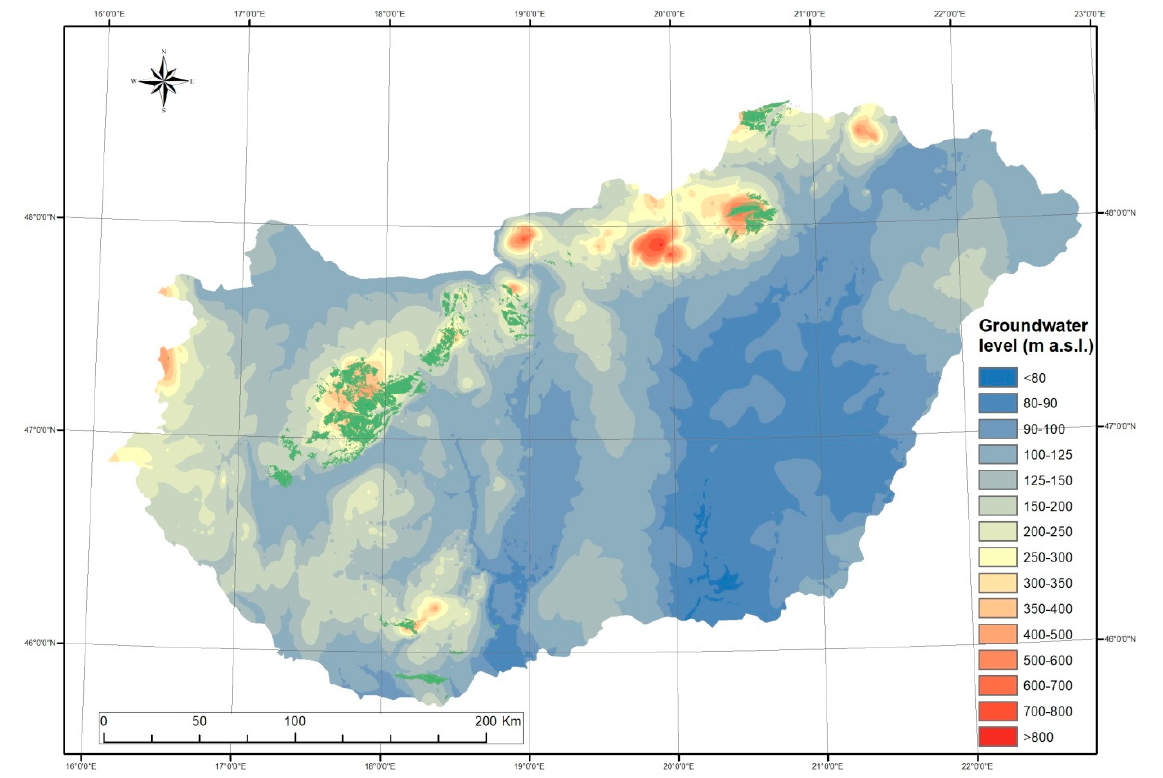
Figure 14. Simulated groundwater table: 1961–1965 average conditions. Green patches indicate unconfined karst areas.